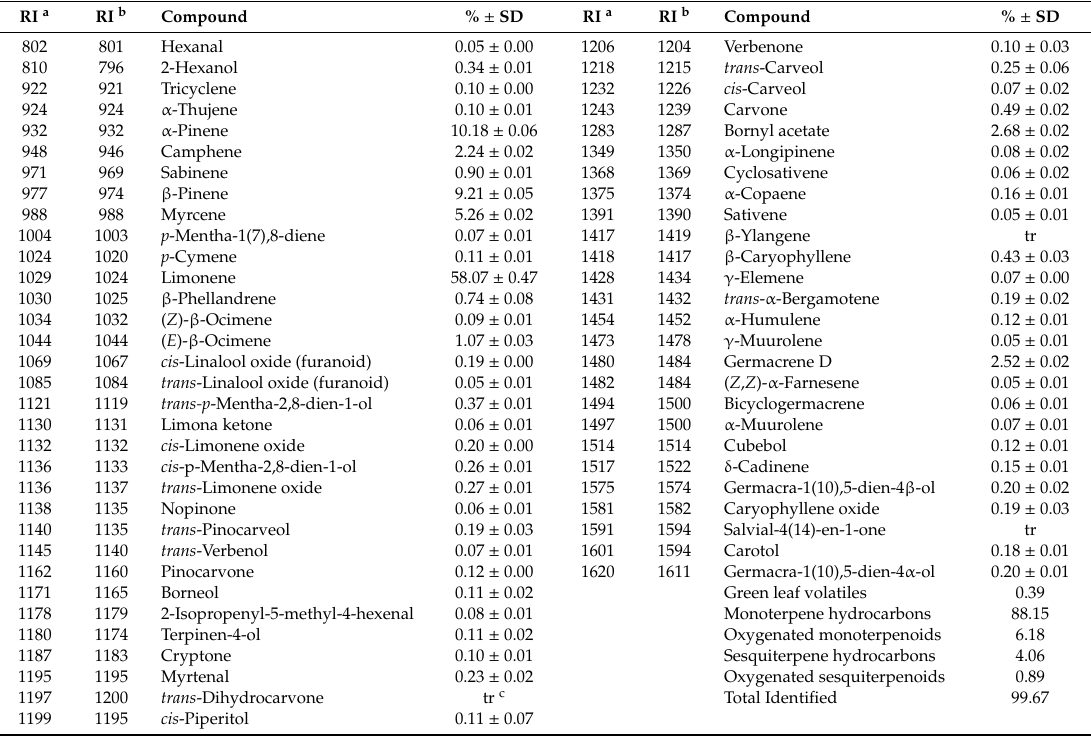
Table 6. Chemical composition of the essential oil of Rudbeckia laciniata